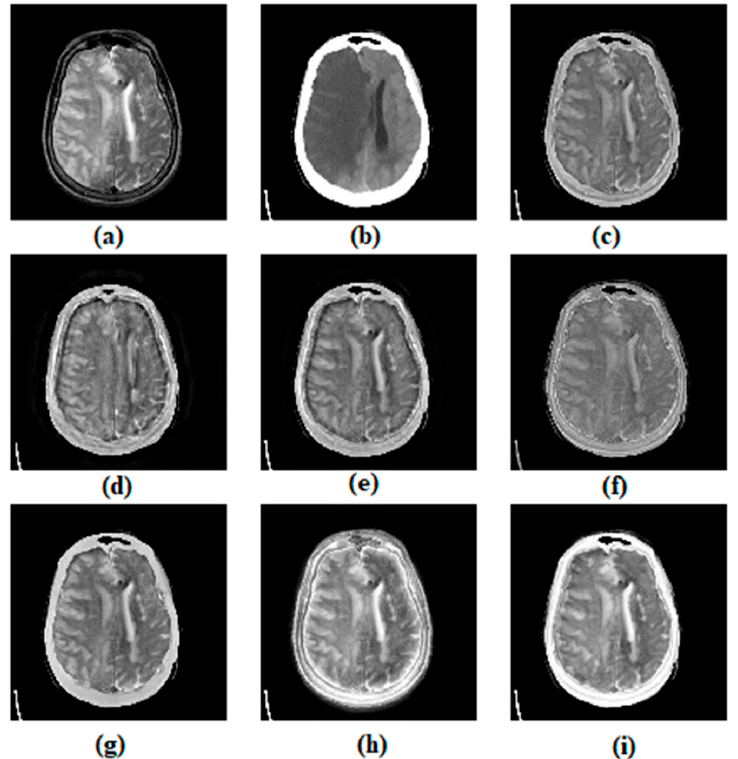
Figure 7. Visual quality analysis of various fusion algorithms for MRI-CT (set-15). ( a ) MRI image, ( b ) CT image, ( c ) ASR, ( d ) CVT, ( e ) DTCWT, ( f ) MSVD, ( g ) CSMCA, ( h ) NSST, ( i ) proposed meth- od.